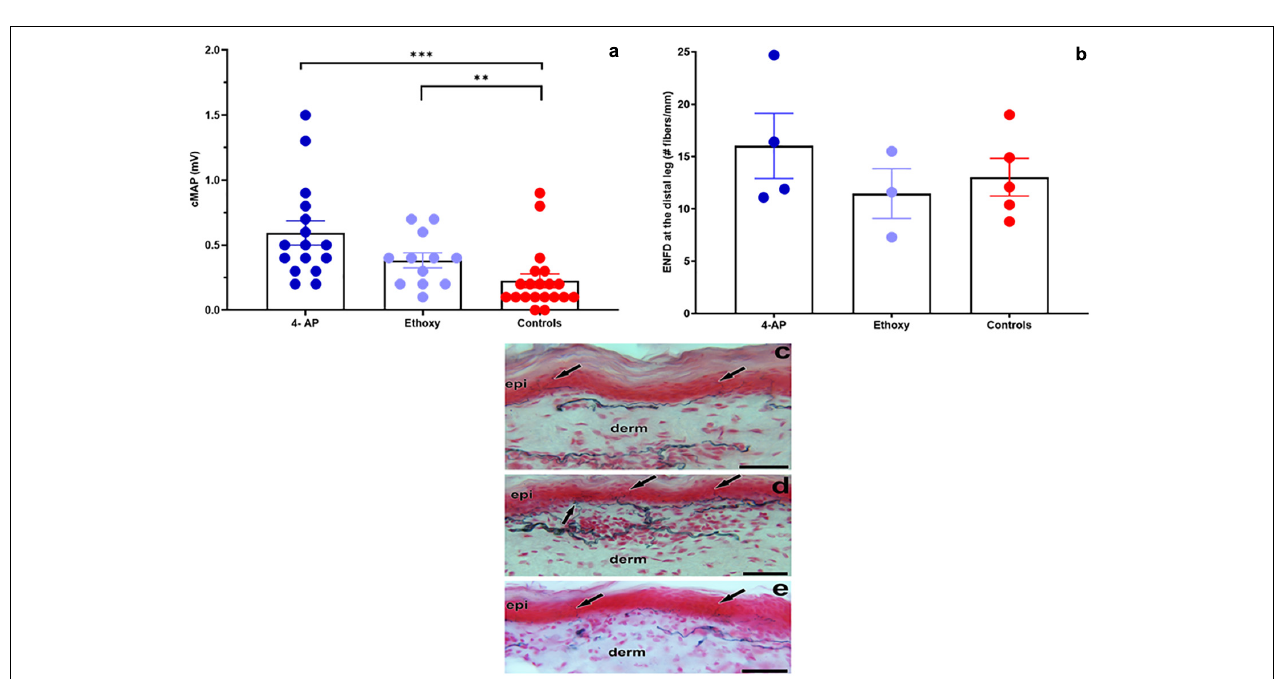
FIGURE 8 | Evaluation of the effect of neuroprotective drugs on NFI in M. leprae infected armadillos. (a) Armadillos treated with 4-Aminopyridine- (4-AP) ( N = 4) and Ethoxyquin (EQ) ( N = 3) showed a significantly higher (*** p = 0.001 and ** p = 0.012, respectively) cMAP (mV) than the untreated controls ( N = 5) at 1 month post-treatment. (b) Epithelial nerve fiber density (ENFD, #fibers/mm) in 4-AP- and EQ-treated and untreated armadillos. (c) Skin section from an untreated armadillo stained with PGP9.5 showing epidermal nerve fibers (arrows) terminating at the epidermis (epi). (d) Skin section from a 4-AP-treated armadillo showing more branching of the epidermal nerve fibers (arrows) and that the dermal nerve bundles are dense at the papillary dermis (derm) in comparison to the untreated armadillo. (e) Skin section from an EQ treated armadillo showing single epidermal nerve fibers (arrows) entering the epidermis. Scale bars = 50 µ